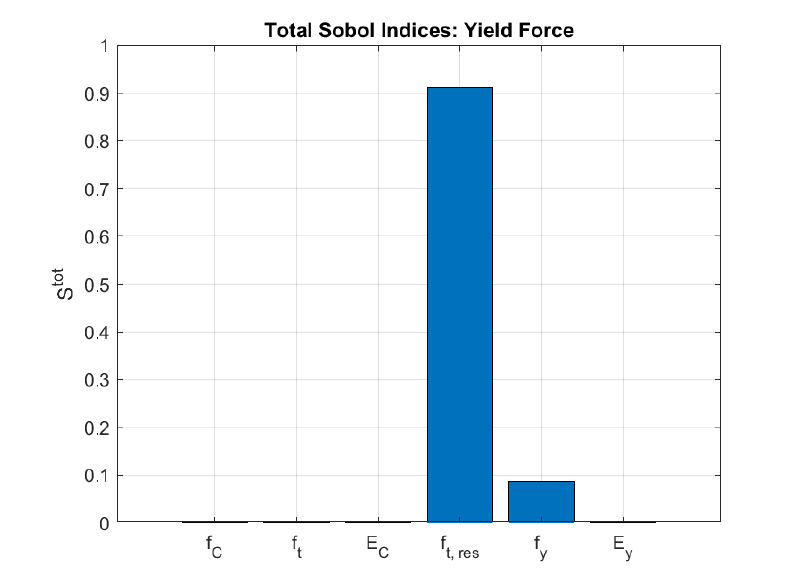
Figure 16. Total Sobol’ indices for yield